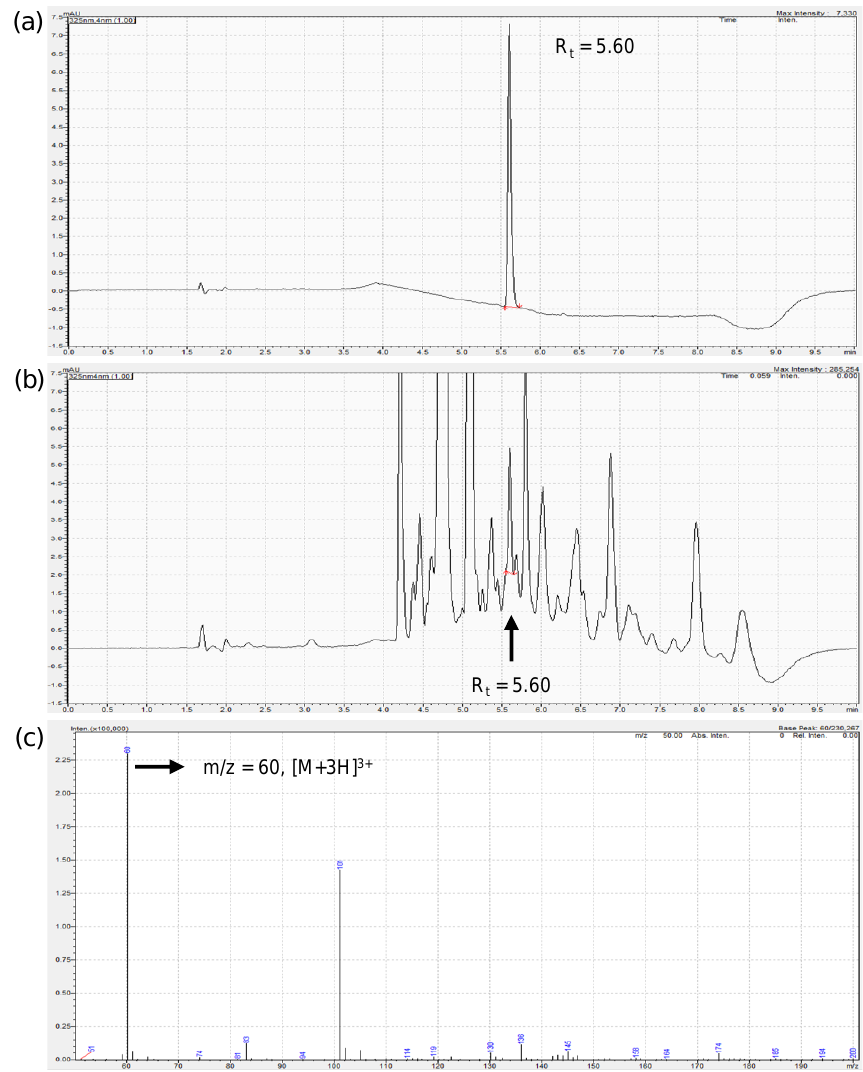
Figure 2. LC-UV chromatography and mass chromatography of DOE showing the presence of daphnetin. ( a ) LC-UV chromatogram of daphnetin. ( b ) LC-UV chromatogram of DOE. ( c ) Mass chromatogram of 5.6 min fraction of DOE from ( b ), corresponding to [M + 3H] 3+ of